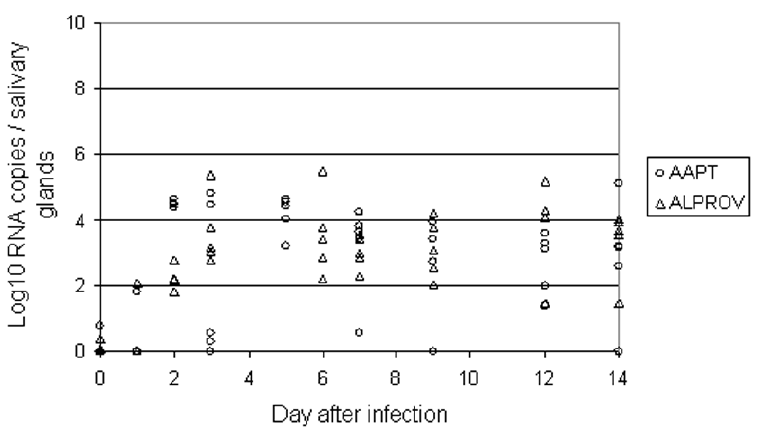
Figure 3. CHIKV transmission by Aedesalbopictus Providence (ALPROV) and Aedesaegypti Petite-Terre (AAPT). At different days after oral infection, transmission was evaluated by detecting viral RNA in salivary glands of 5 females by real-time RT-PCR.